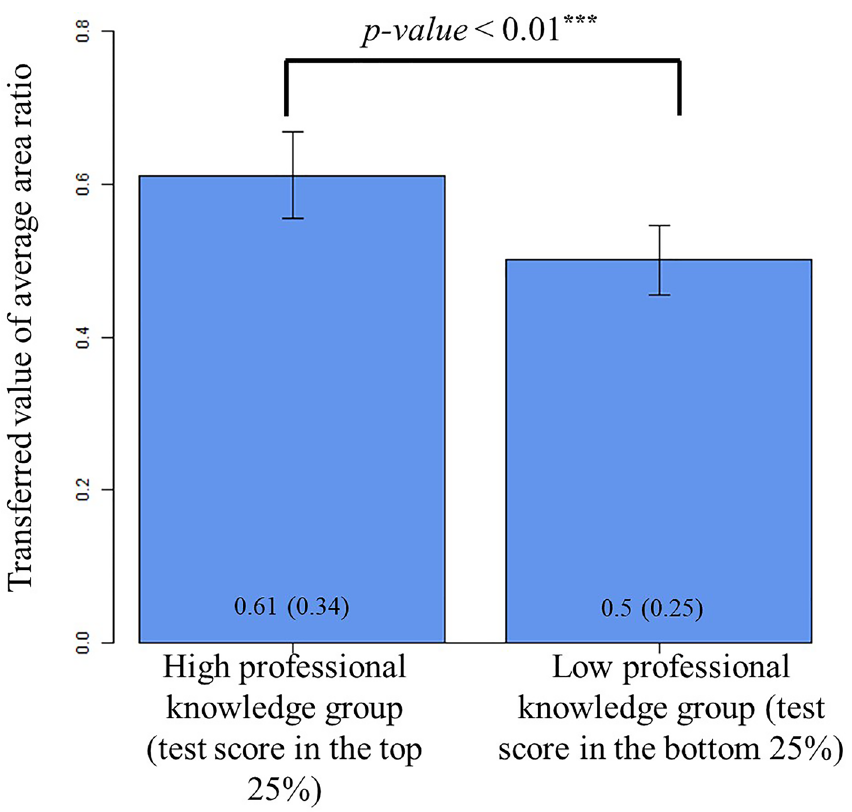
Figure 2. Illustration of the average area ratio of the high and low professional knowledge groups in the survey data. The left bar shows the average area ratio of the high professional knowledge group (i.e., participants with the top 25% of the test scores) while the right, that of the low professional knowledge group (i.e., participants with the bottom 25% of the test scores). The numbers inside each bar represent transformed values of the average area ratios under the arcsine transformation. The numbers inside the parentheses represent the raw average area ratios before the transformation.